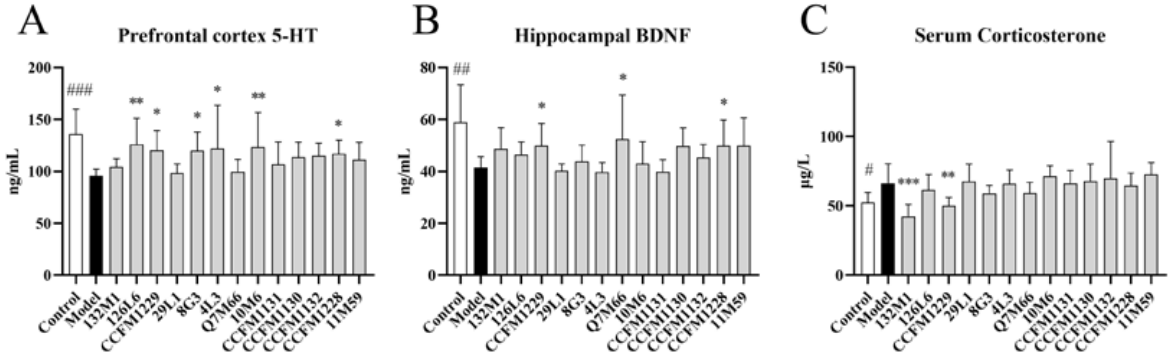
Figure 3. Effect of Lactobacillus on brain and neuroendocrine system. ( A ) Prefrontal cortex 5-HT levels. ( B ) BDNF concentration of the hippocampus. ( C ) Serum corticosterone levels. # p < 0.05; ## p < 0.01; ### p < 0.001; * p < 0.05; ** p < 0.01; *** p < 0.001 comparing with depression group; n = 7–9.